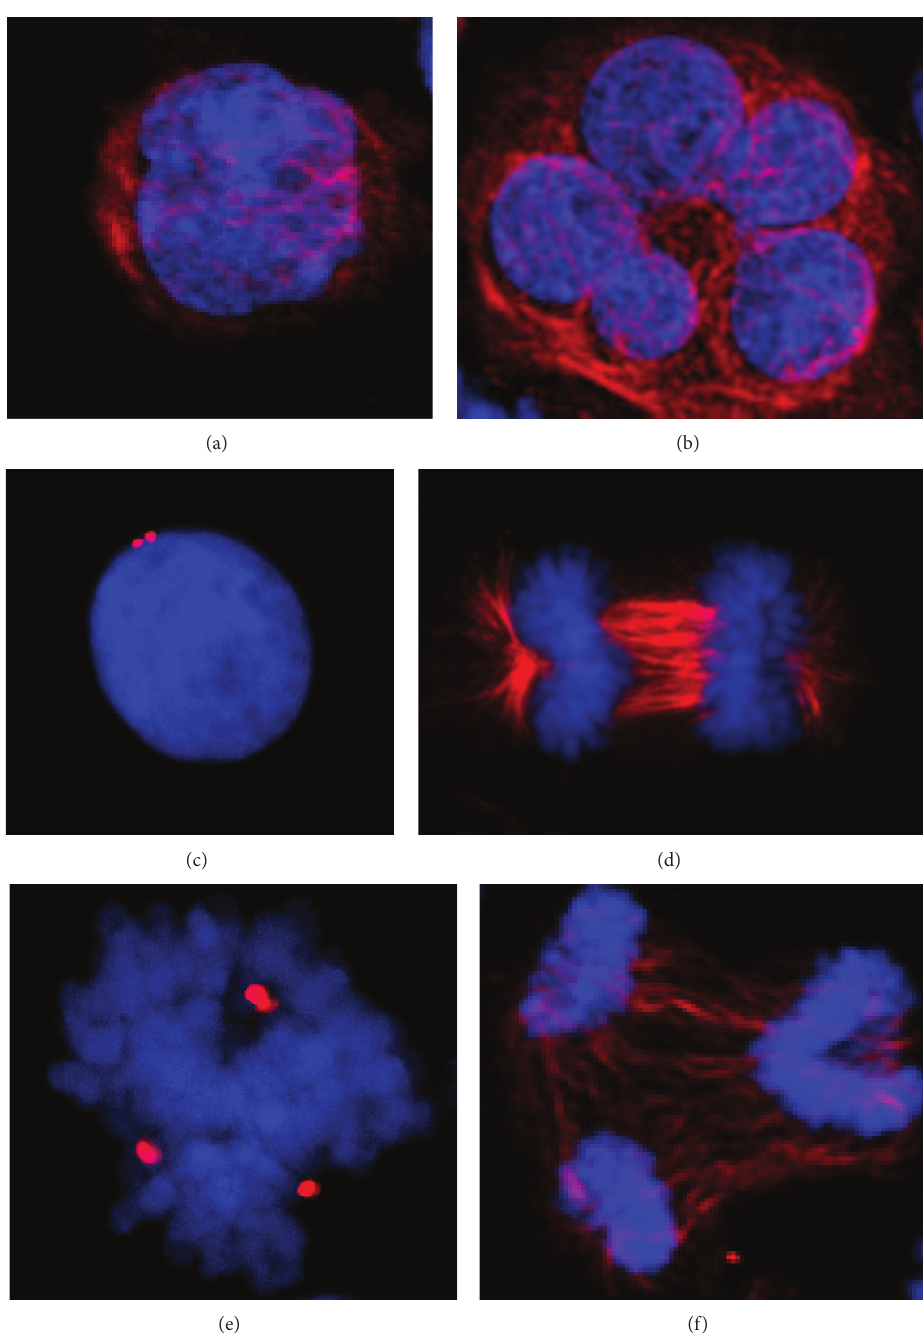
Figure 1: Morphological features of mitotic catastrophe. Human K562 chronic myeloid leukaemia cells during normal interphase (a) and a giant multinucleated cell following mitotic catastrophe induced by microtubule disruption (b). Interphase cell with two centrosomes (c) and normal chromosome segregation during anaphase (d). A cell containing > 2 centrosomes (e) forms multipolar mitotic spindles (f) leading to aneuploidy as a result of mitotic catastrophe failure. DNA (blue), 𝛼 -tubulin (red) (a, b, d, f), and centrosome (red pericentrin staining) (c and